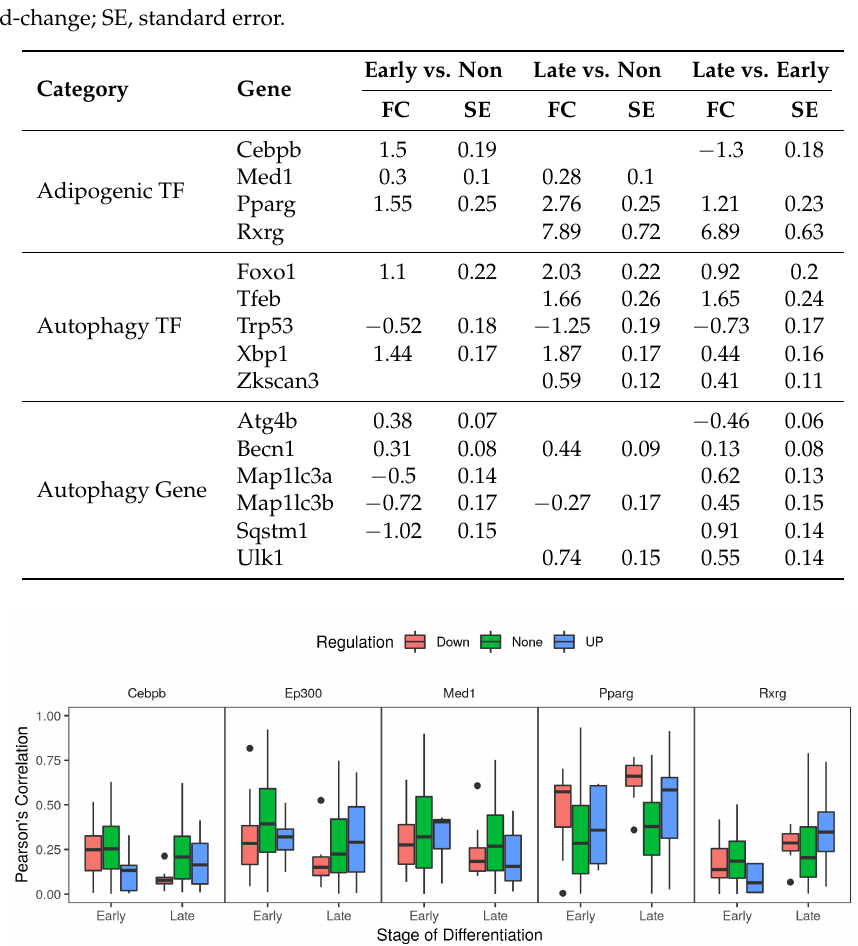
Figure 3. Co-expression of autophagy products with adipogenic transcription factors. The read counts of five genes coding for adipogenic transcription factors/co-factors and 158 autophagy genes were used to calculate the co-expression values of each of the factors with autophagy genes. Pearson’s correlation co-efficient were calculated from RNA-Seq samples (n = 66) of MDI-induced 3T3-L1 cells in three differentiation stages; non, early and late differentiating cell. Genes were stratified by their differential expression into down- (red), none- (green) or up-regulated